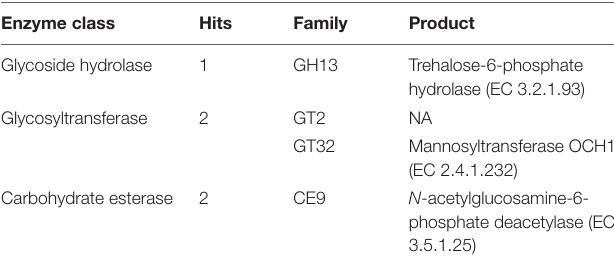
TABLE 1 | Carbohydrate-active enzymes in the genome of Hepatoplasma crinochetorum based on the CAZy database (Cantarel et al., 2009; Lombard et al.,